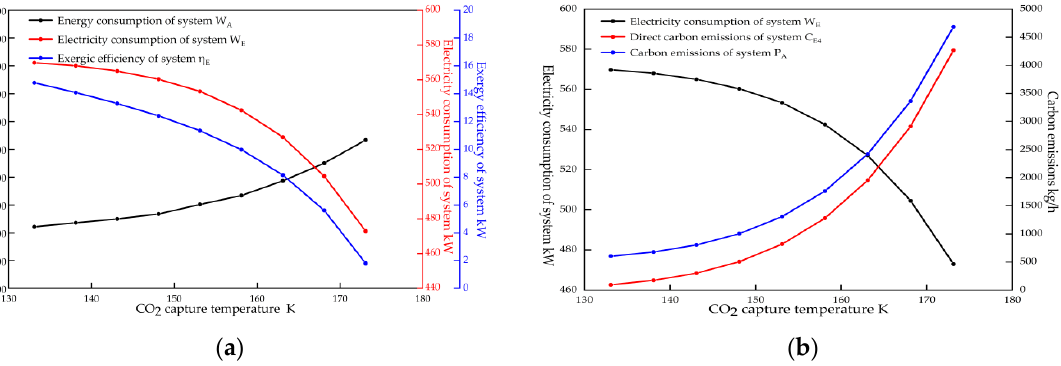
Figure 9. The effect of CO 2 capture temperature on system performance. ( a ): System energy consumption and exergy efficiency; ( b ): System electricity consumption and carbon emissions.